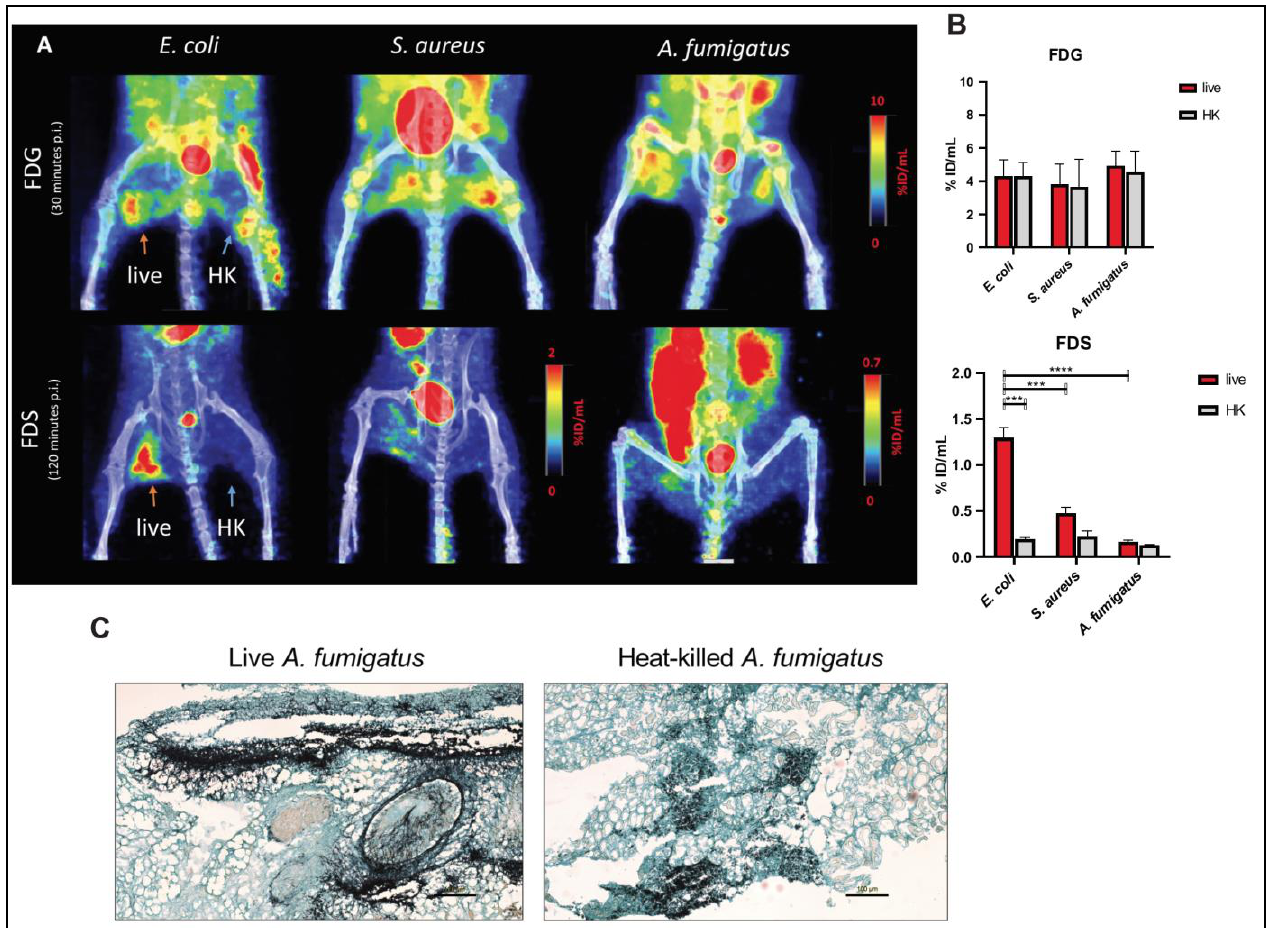
Figure 4. Static 18 F-fluorodeoxyglucose (FDG) and 2-[ 18 F]-fluorodeoxysorbitol (FDS) PET/CT imag- ing of E. coli , S. aureus, and A. fumigatus myositis models. ( A ) Maximum intensity projections (MIPs) of representative PET/CT images and ( B ) quantified uptake values (%ID/mL) show high FDG uptake in both live (orange arrows) and heat-killed injection sites (blue arrows) in all three models. FDS uptake, on the other hand, is highest in association with live E. coli with no appreciable uptake seen on the heat-killed side. S. aureus and A. fumigatus models show higher FDS uptake in the live versus heat-killed (HK) thighs, however, the uptake associated with live infection is much lower than that seen in live E. coli model. ( C ) GMS staining of muscle slices from live and heat-killed (HK) A. fumigatus inoculated thighs. Scale bars, 100 µm. Data are expressed as means ± SEM. ***, p < 0.001. ****, p < 0.0001. (%ID/mL: %Injected dose/mL).